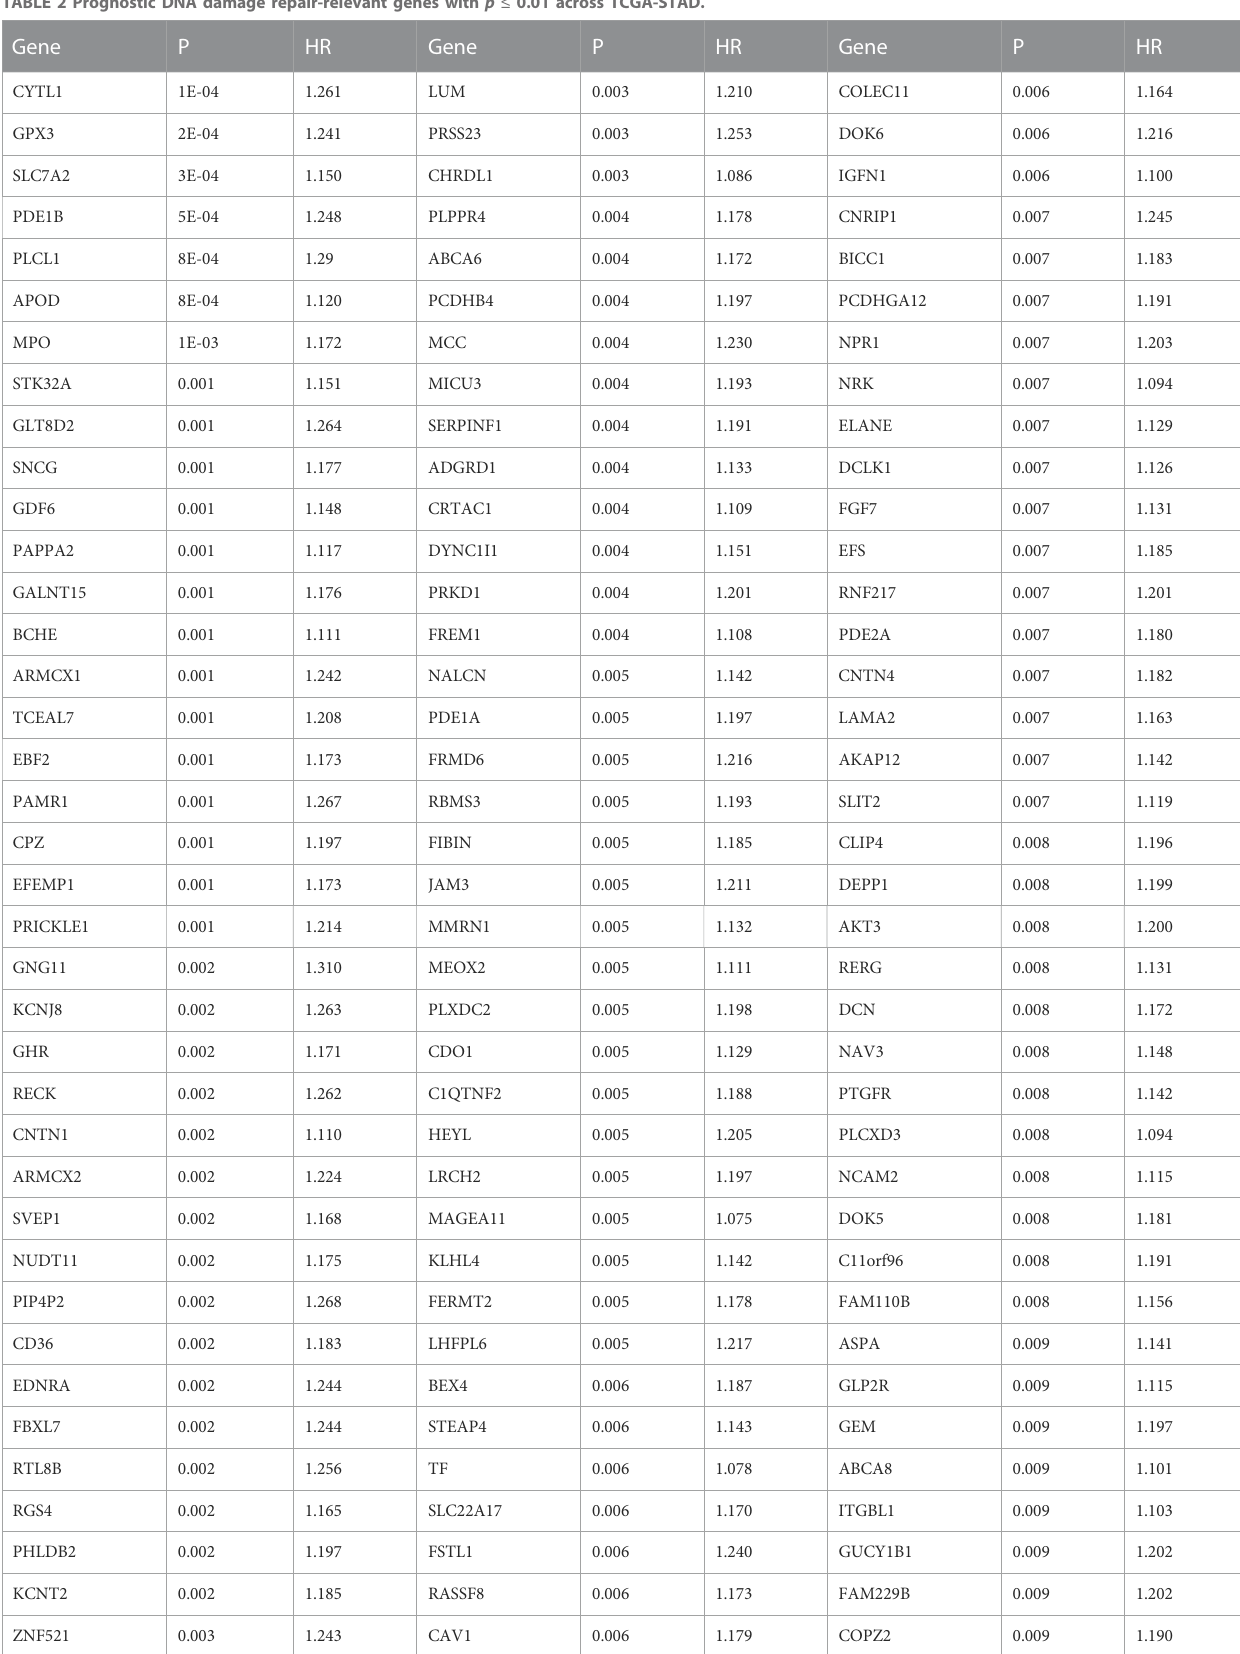
TABLE 2 Prognostic DNA damage repair-relevant genes with p ≤ 0.01 across TCGA-STAD. Gene P HR Gene P HR Gene P HR